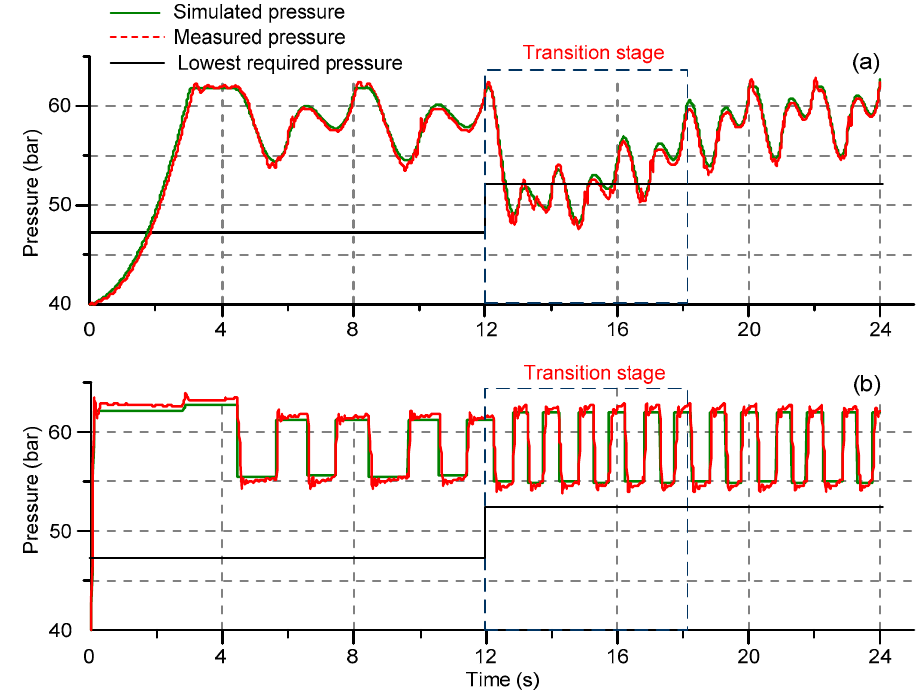
Figure 9. Comparison of two pressures of the two accumulator systems when the sine signal frequency suddenly increases from 0.25 Hz to 0.5 Hz: ( a ) pressure of the traditional accumulator; ( b ) pressure of the new